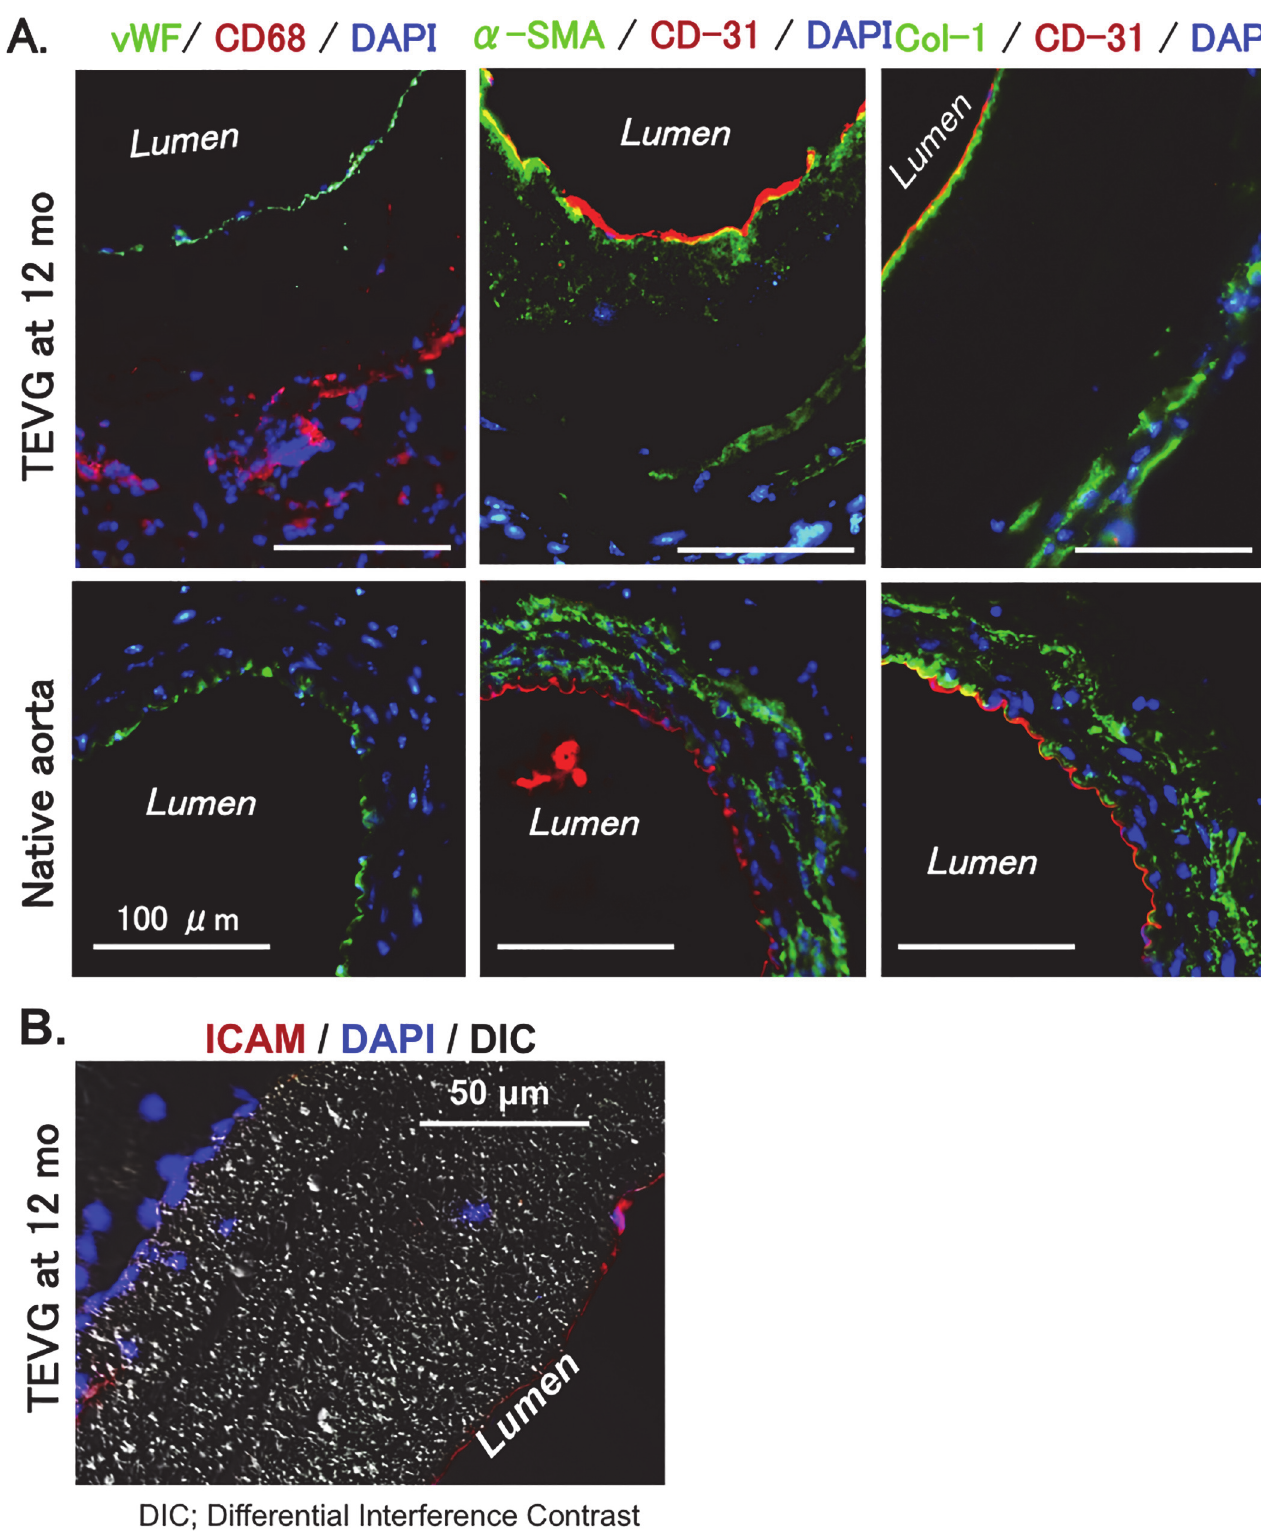
Fig 8. Expression of vascular cell markers in TEVG was similar to that of native aorta. A. Immuno-labeling of vascular cell markers on cross-sections of TEVG and native aorta. Left panel: von Willebrand factor (vWF, green), an endothelial cell marker and CD68 (red), a macrophage marker. Middle panel: